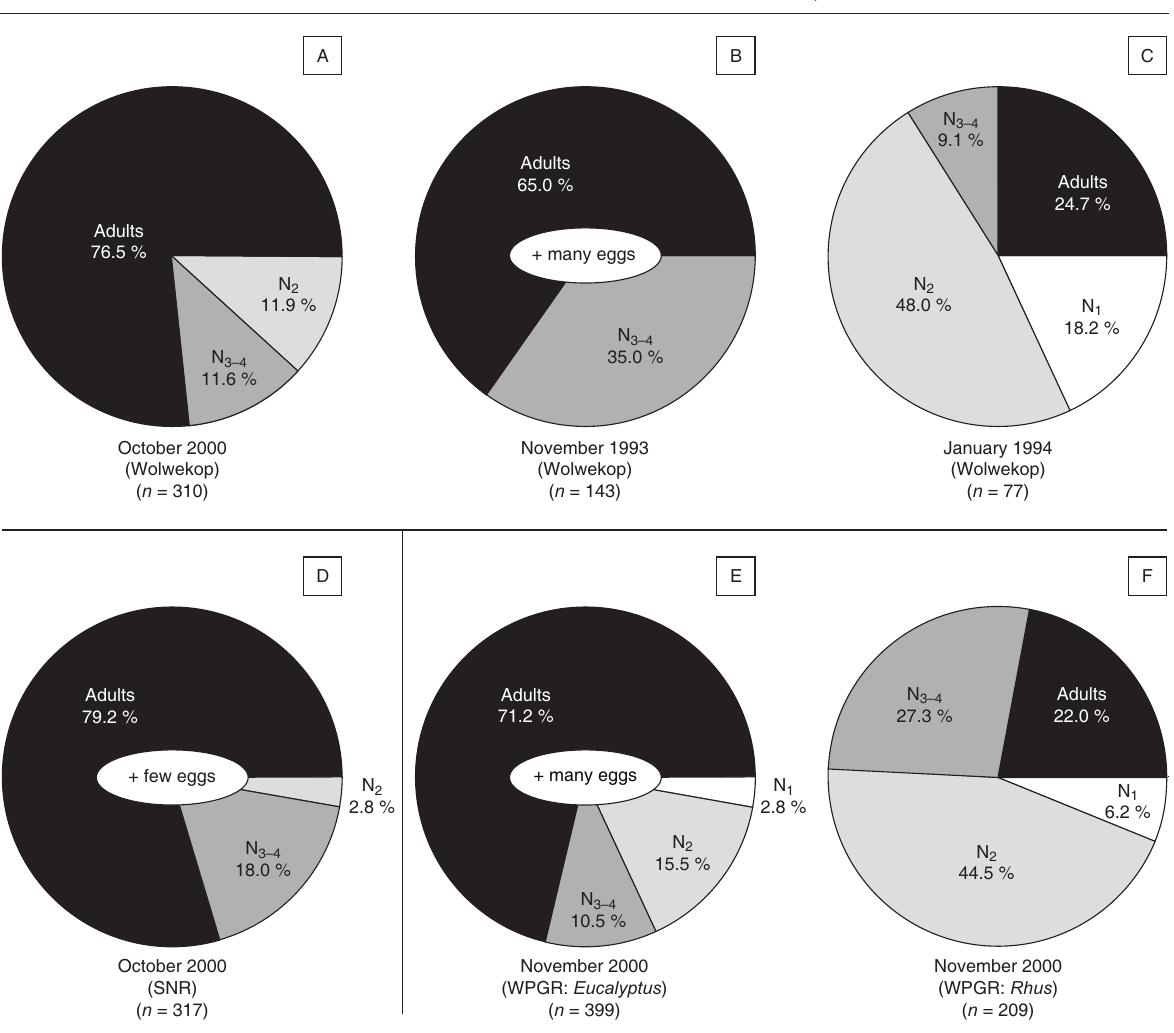
FIG. 1 Population structure of Argas arboreus at Wolwekop (A, B, C), Soetdoring Nature Reserve (SNR; D) and Willem Pretorius Game Reserve (WPGR; E, F) heronries, South Africa. Data of figures B and C from Belozerov & Kopij (1997)